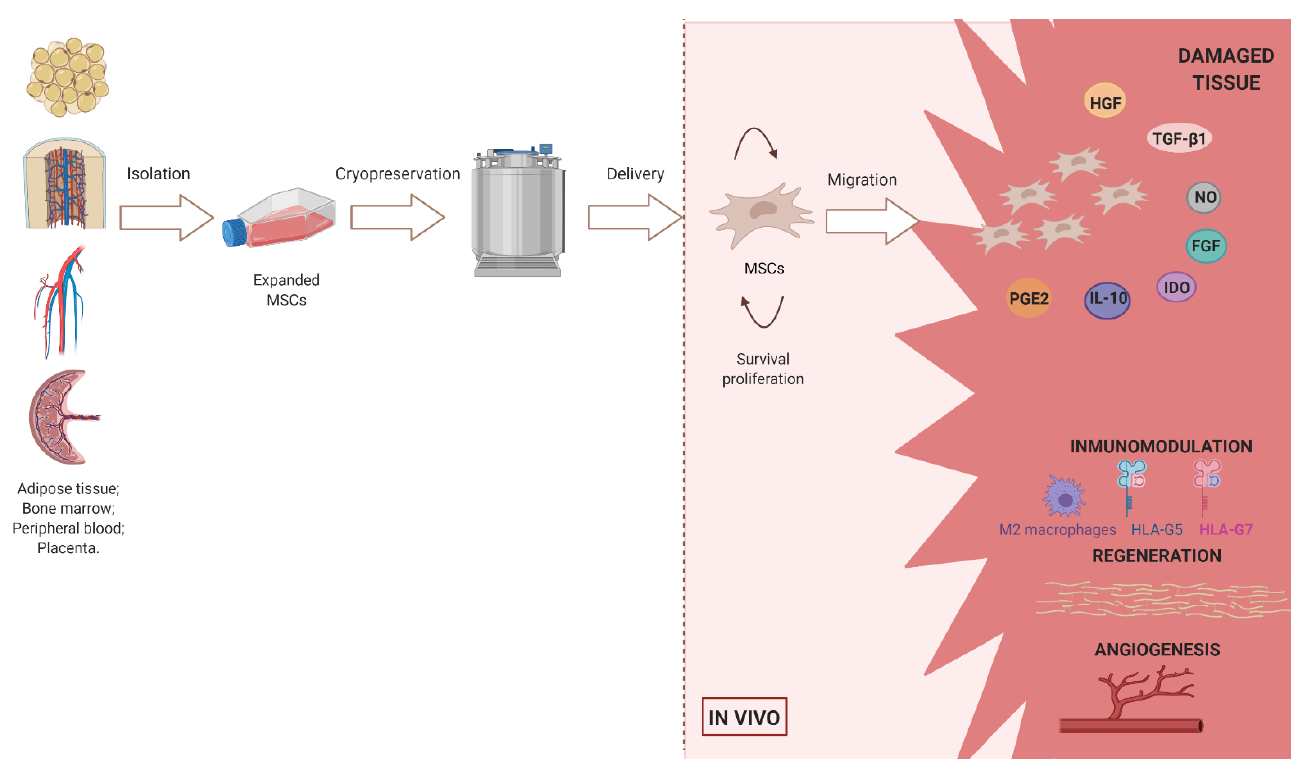
Figure 1. This scheme summarizes the entire MSC manufacturing process for allogeneic cellular therapy and its subsequent function in the recipient tissue. The secretion of cytokines and other factors such as NO, IDO, HGF, FGF, IL-10, PGE2 and TGF- β1 contribute to the tissue repair processes that can be summarized in three points: 1) Immunomodulation; 2) Regeneration; and 3) Angiogenesis. Created with BioRender.com .